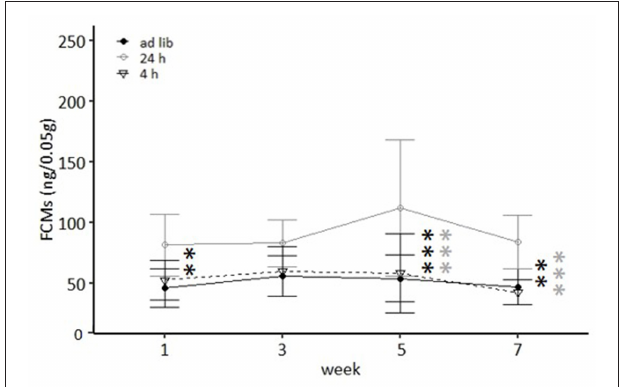
FIGURE 5 | Levels of fecal corticosterone metabolites (FCMs). Ad lib , Ad libitum group; 24h, 24h schedule group; 4h, 4h removal group. Data presented as means ± SD. Statistics, repeated measures ANOVA; Post hoc , Bonferroni-Holm corrected; sample size: n = 12 per group; ** p < 0.01, *** p < 0.001. Gray asterisks: comparison 24 and 4h, black asterisks: comparison ad lib and 24 h.